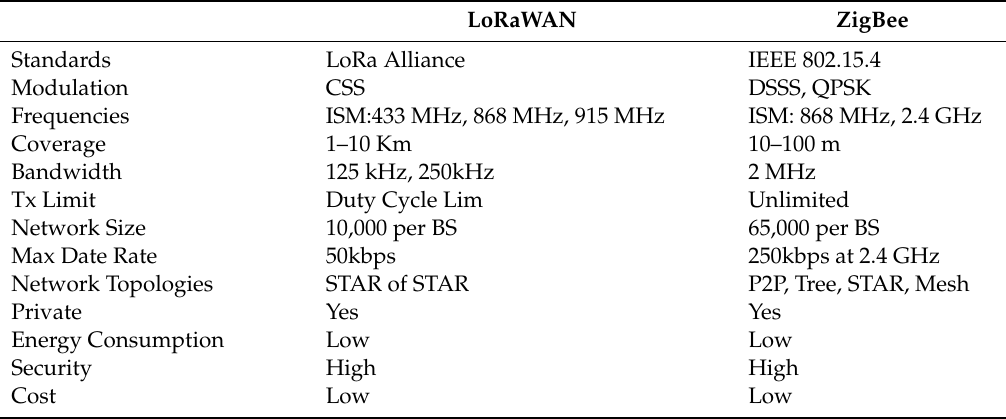
Table 1. Comparison of the LoRaWAN and Zigbee.